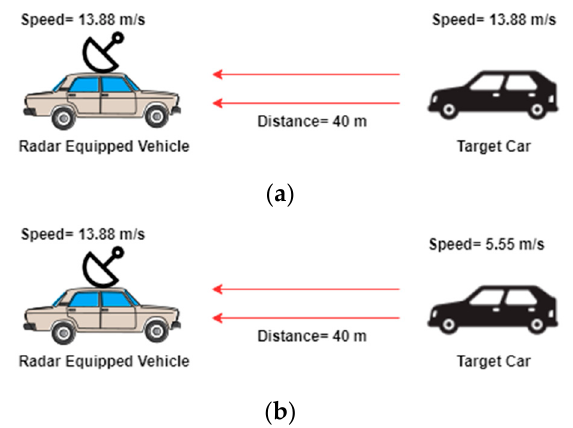
Figure 6. FMCW radar scenarios ( a ) Scenario 1 ( b ) Scenario 2.